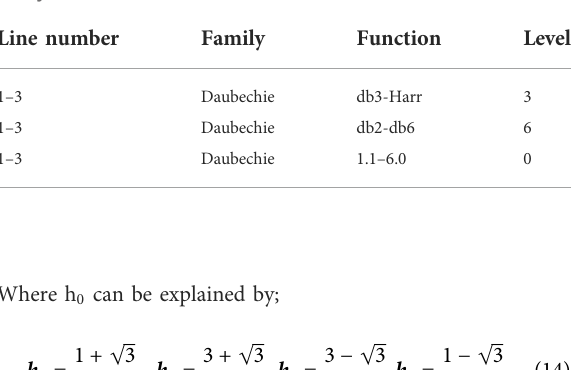
TABLE 2 Wavelet functions and their application level along with the